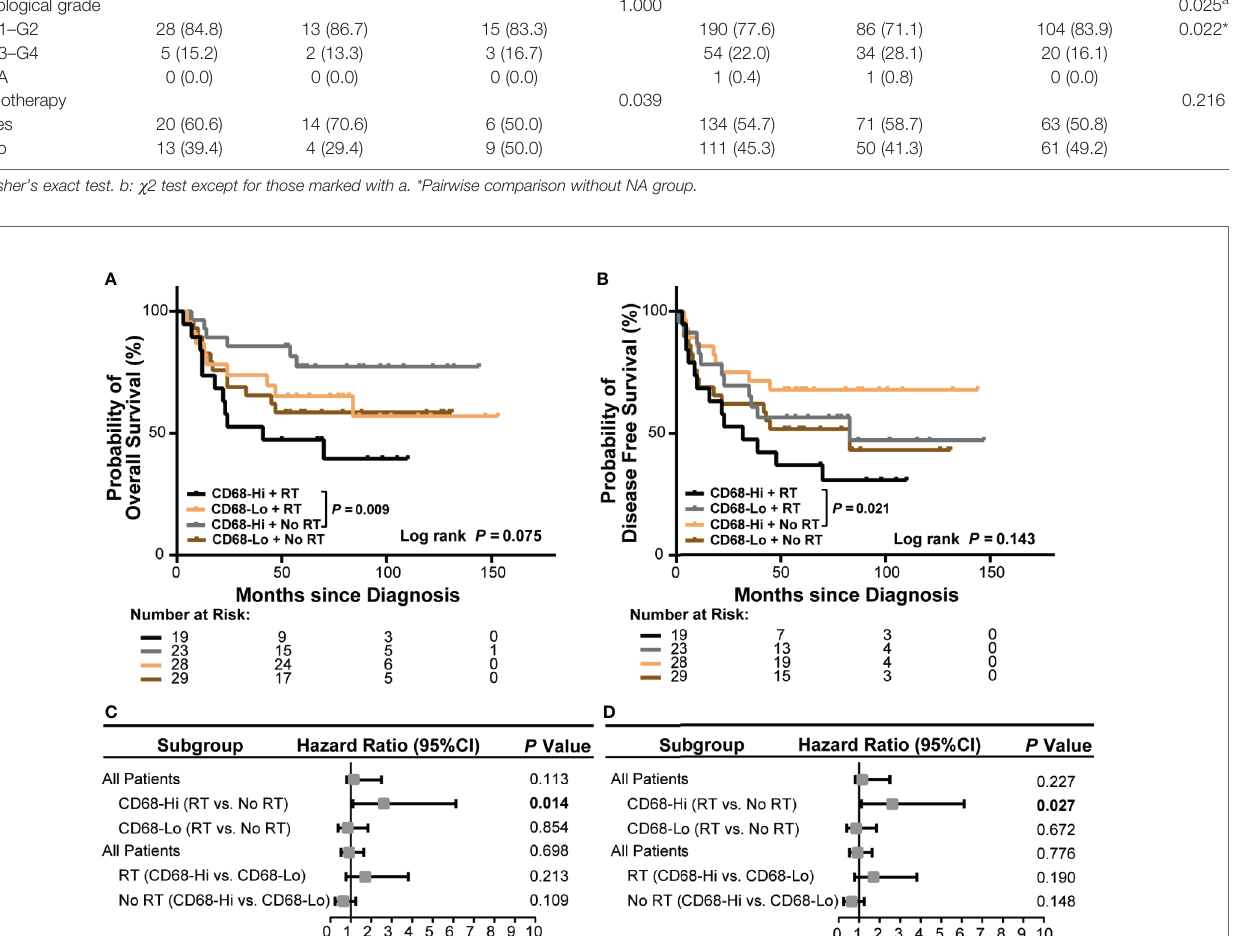
Frontiers in Oncology |